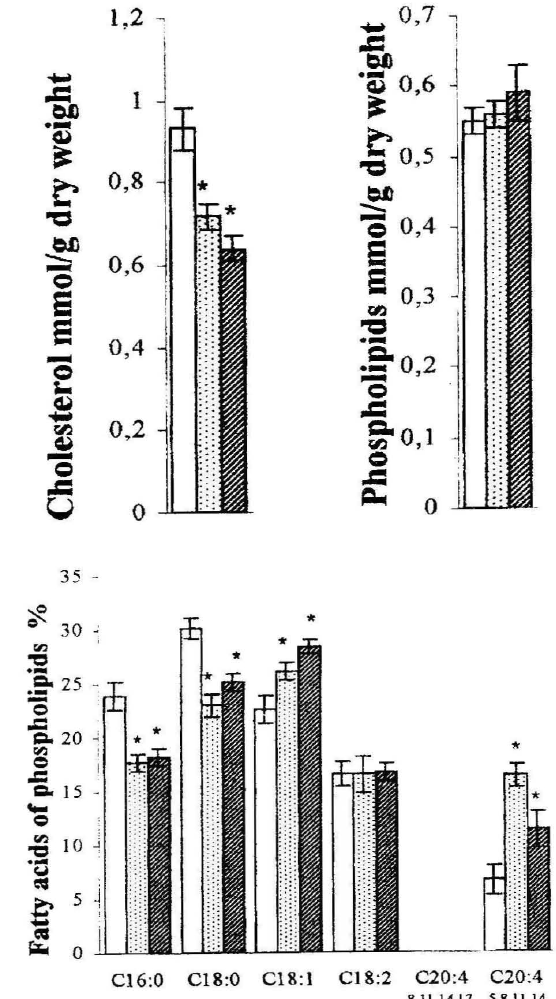
Fig. 13. Concentrations (mean ± SD) of cholesterol and phospholipids, as well as fatty acid content in per cent (mean ± SD) of phospholipids in control samples (open bars), and in samples with 0.2 runol L-trypto phan/g wet weight (dotted bars), or with 20 runol L tryptophanlg wet weight (hatched bars). Samples ofrat liver tissue homogenate were used to test for phospho lipid biosynthesis in vitro. Incubation medium: